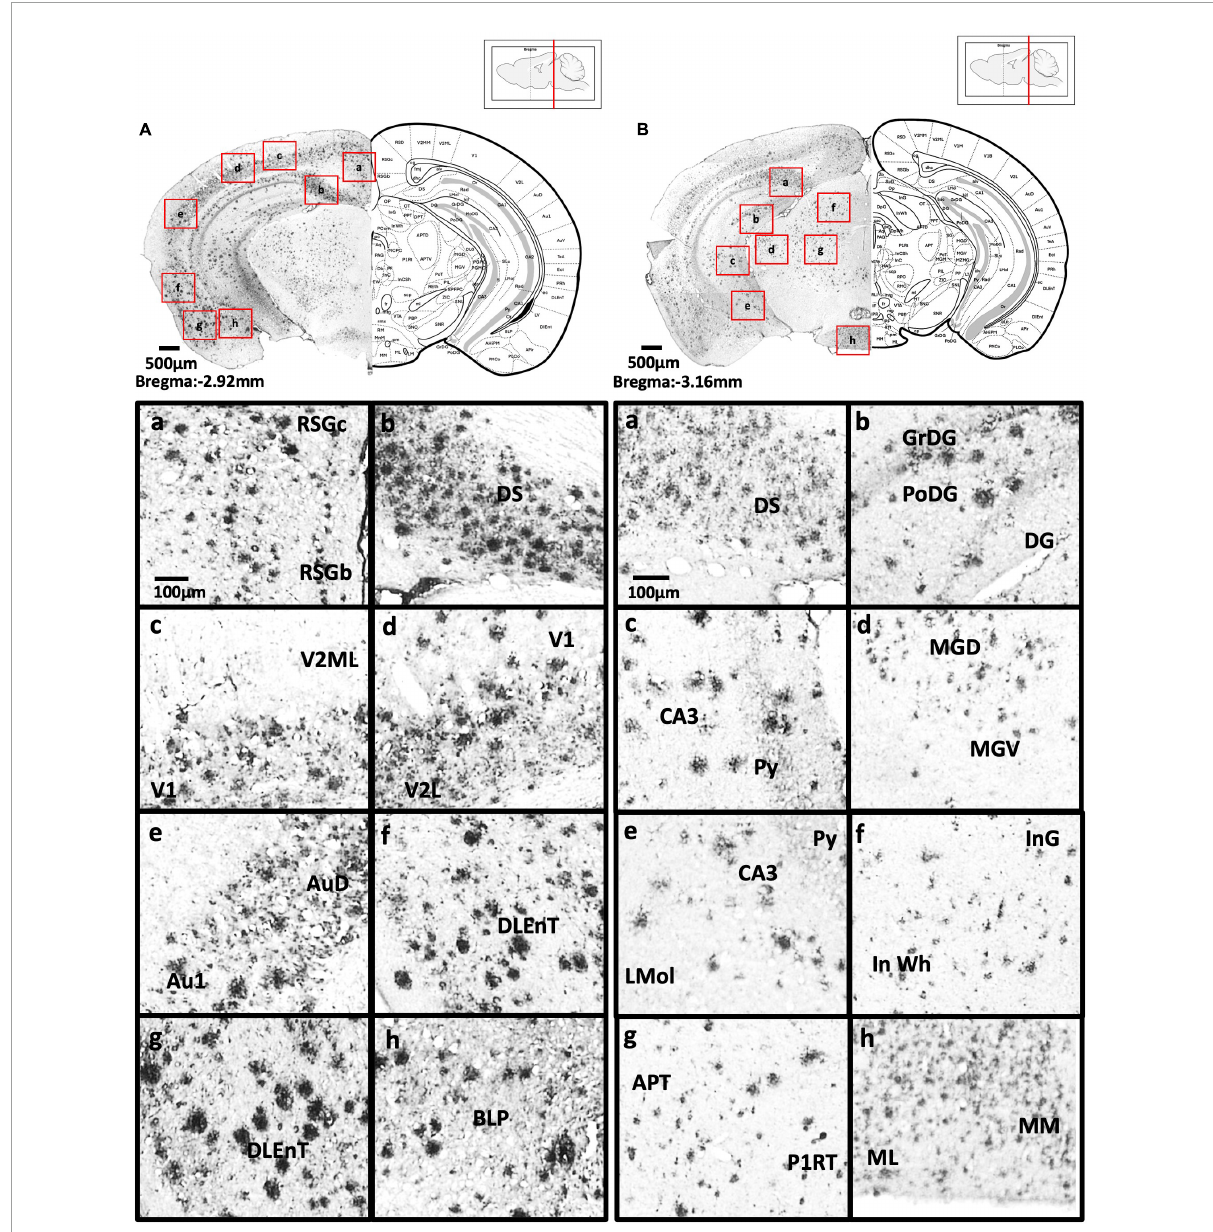
FIGURE6 (A) Coronal section through the midbrain showing A β deposition in the B region and C region of the retrosplenial granular cortex (a), dorsal subiculum (b), primary visual cortex, mediolateral area in the secondary visual cortex (c), primary visual cortex, lateral secondary visual cortex (d), primary auditory cortex, dorsal auditory cortex (e), dorsolateral entorhinal cortex (f), dorsolateral entorhinal cortex (g), and posterior basolateral amygdaloid nucleus (h). (B) Coronal section through the midbrain showing A β deposition in the dorsal subiculum (a), dentate gyrus (b), CA3 field and pyramidal tract (c), dorsal and ventral medial geniculate nucleus (d), pyramidal tract, CA3 field, and lacunosum molecular layer of the hippocampus (e), intermediate gray layer of the superior colliculus, intermediate white layer of the superior colliculus (f),